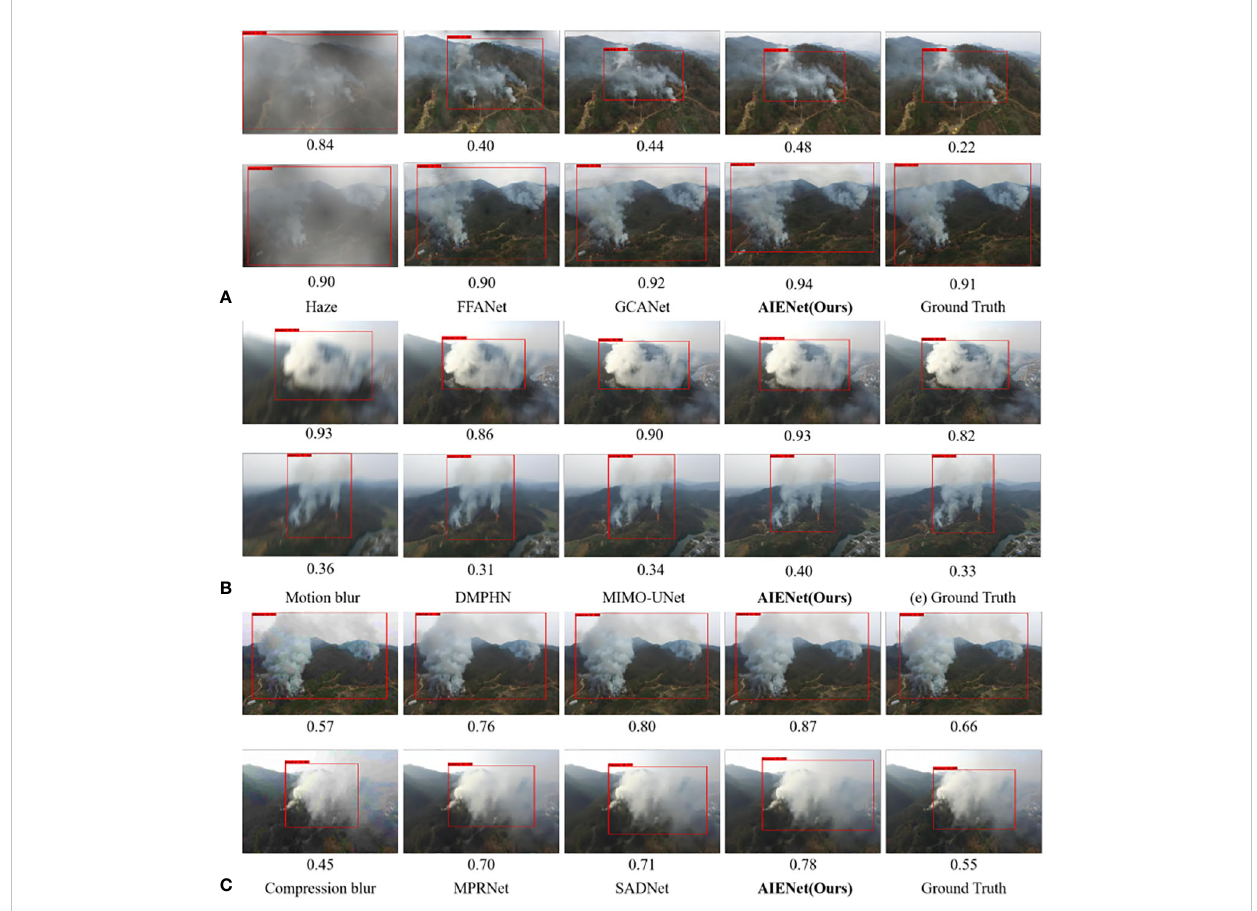
FIGURE 9 Qualitative comparison of our model with other works in improving fi re detection performance. (A) is the visual comparison of image dehazing results. (B) is the visual comparison of image motion deblurring results. (C) is the visual comparison of image compression deblurring results.